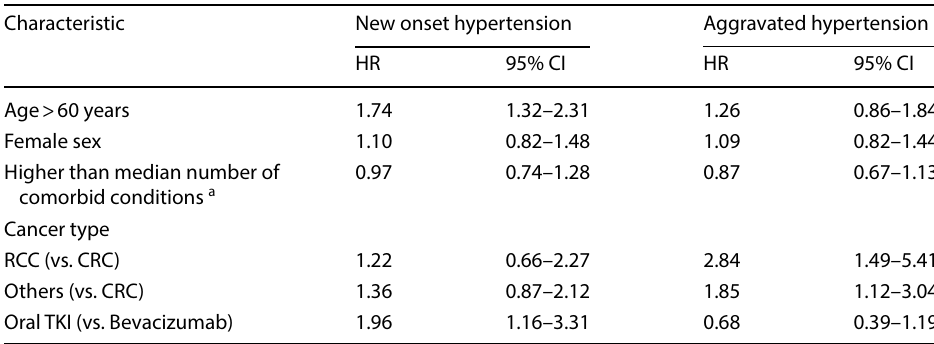
Table 3 Risk factors for new-onset and aggravated hypertension after VSPi in multivariable